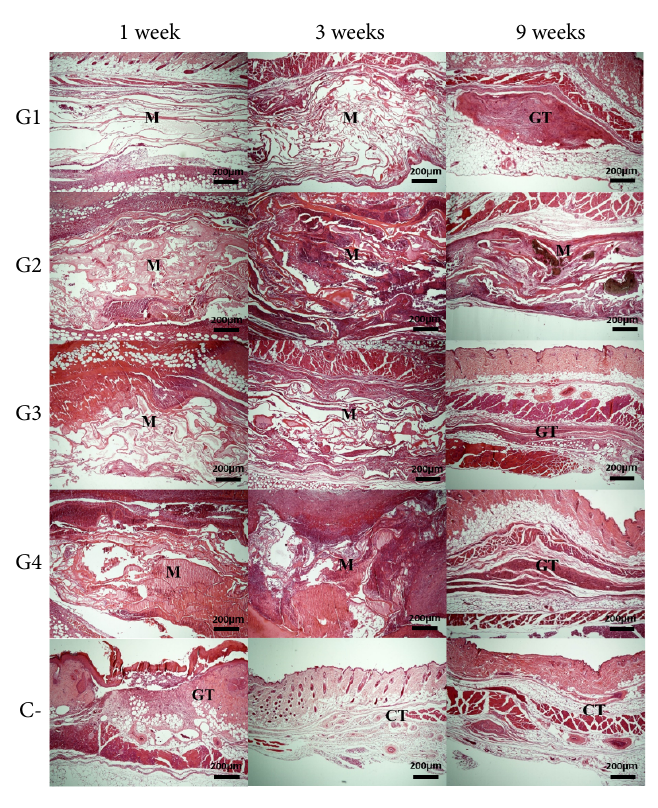
Figure 5 - Biodegradability analysis of poultry collagen-based hydrogels in subcutaneous tissue in mice at one, three and nine